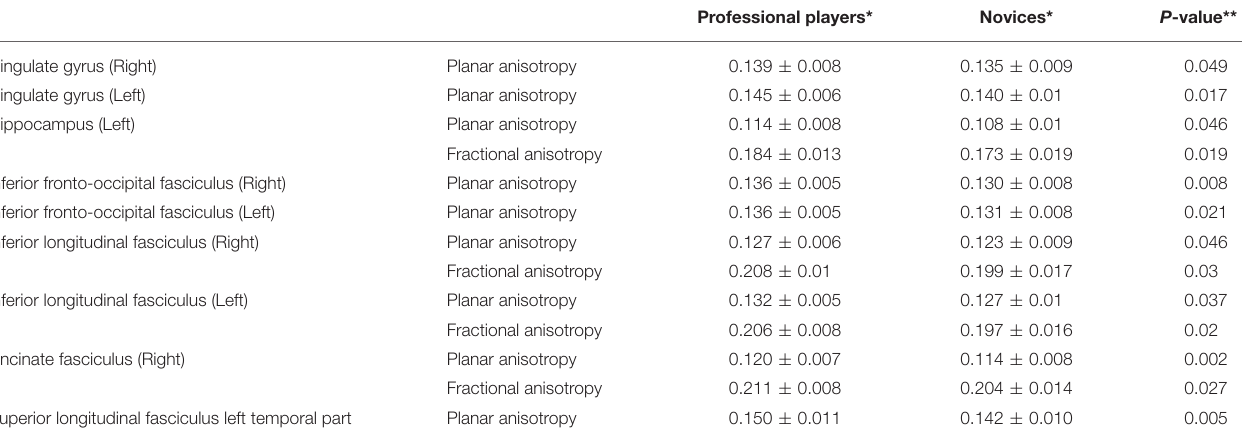
TABLE 1 | Differences in diffusometric values of gray and white matter structures based on Mori